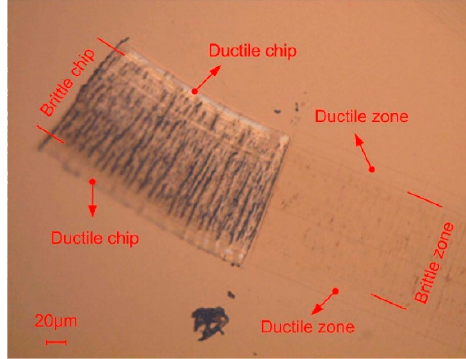
Figure 9. Topography of the machined zone and chip in groove cutting test [74].